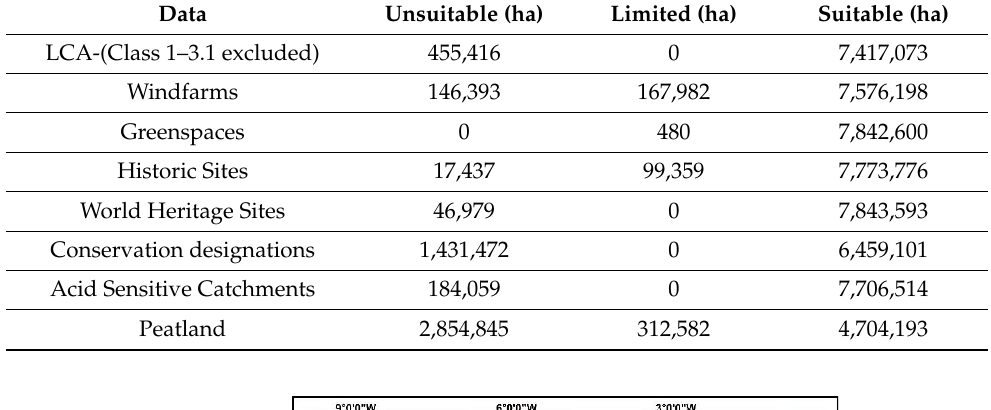
Table 8. Unsuitable/limited/suitable areas based on current policy constraints in Scotland.